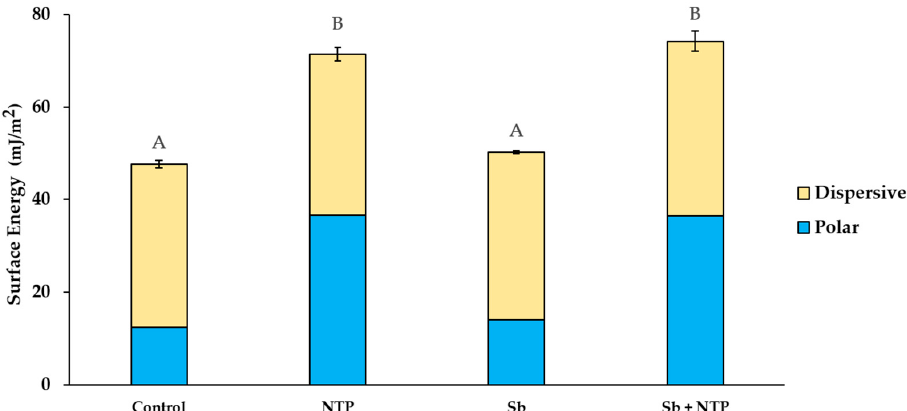
Figure 6. Means of polar and dispersive components of SE of Y-TZP for the Control, NTP, Sb, and Sb + NTP group. The sum of the two components represents the value of SE of Y-TZP. The different upper case letters indicate significant differences among different surface treatments ( p < 0.05).